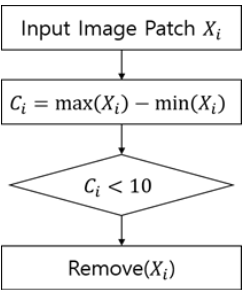
Figure 7. Flow chart of contrast ratio-based filtering.